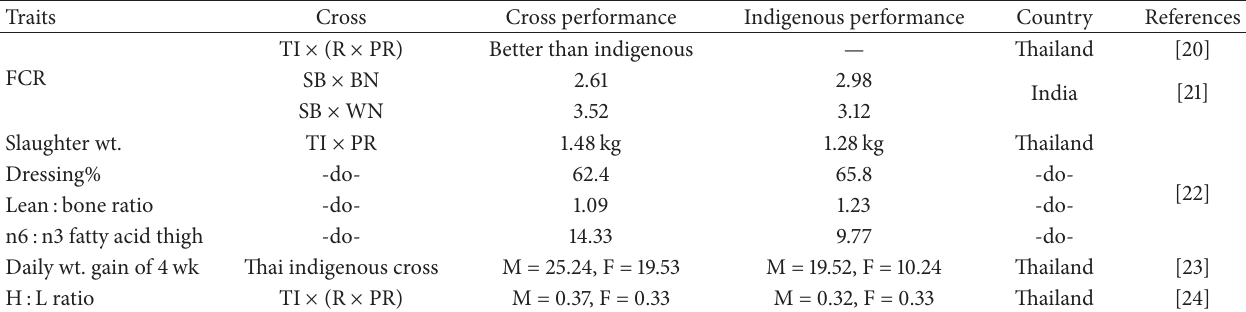
Table 1: Effect of crossbreeding using indigenous birds with respect to feed conversion ratio, slaughter parameters, weight gain, and Heterophils/Lymphocytes (H/L) ratio. Traits Cross Cross performance Indigenous performance Country Better than indigenous